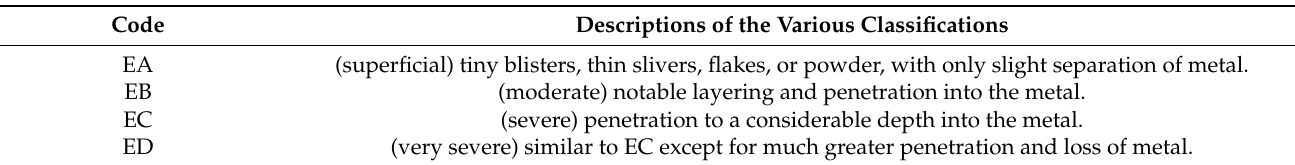
Table 5. The degree of corrosion of E grade breakdown level was described.